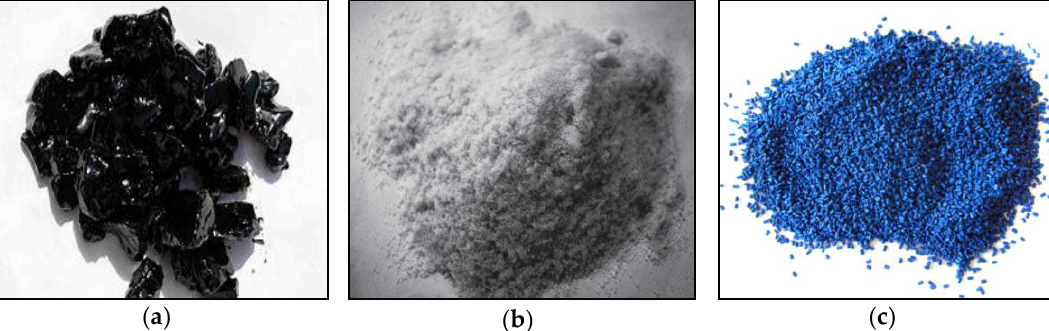
Figure 2. ( a ) Bitumen sample; ( b ) powdered polyurethane foam (PUF); ( c ) shredded grains of plastic waste (PW).